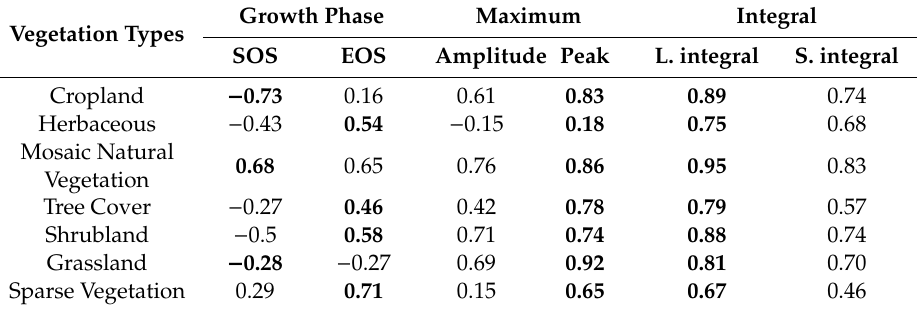
Table 3. The correlation coefficients of phenological indicators and the NDVI trend for vegetation types.